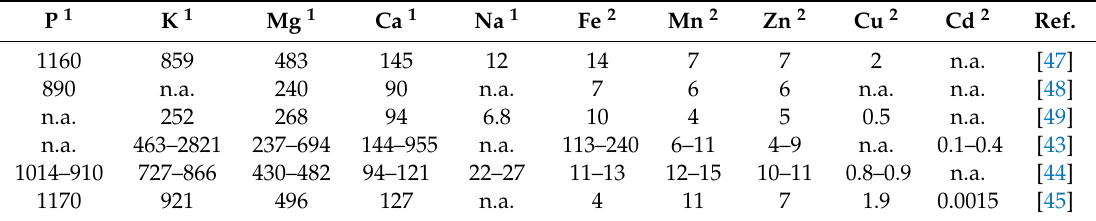
Table 7. Hempseed mineral composition value (mg / 100 g) of di ff erent industrial hemp cultivars . P 1 K